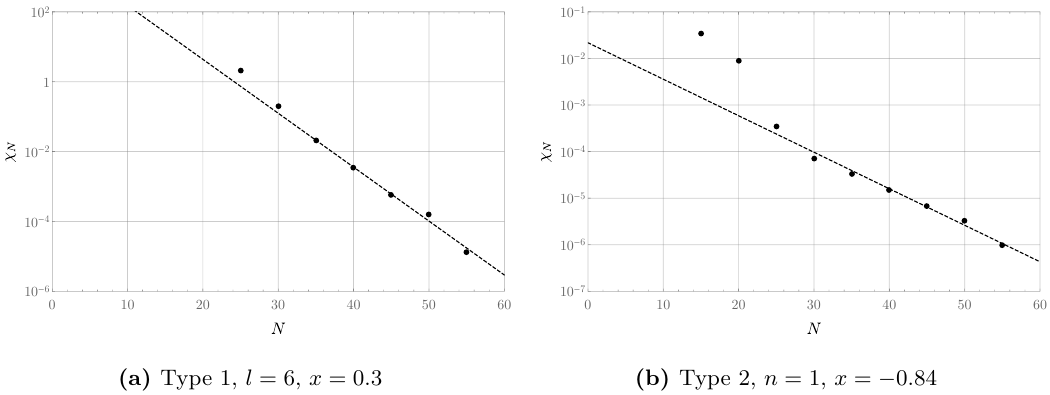
Figure 12 . The vanishing of the relative error χ N in the Casimir energy with increasing numerical resolution. Figure (a) shows the Type 1 deformation (2.5) with l = 6 and x = 0 . 3 , while figure (b) shows the Type 2 deformation (2.7) with n = 1 and x = − 0 . 84 . The dashed best-fit lines show the expected exponential